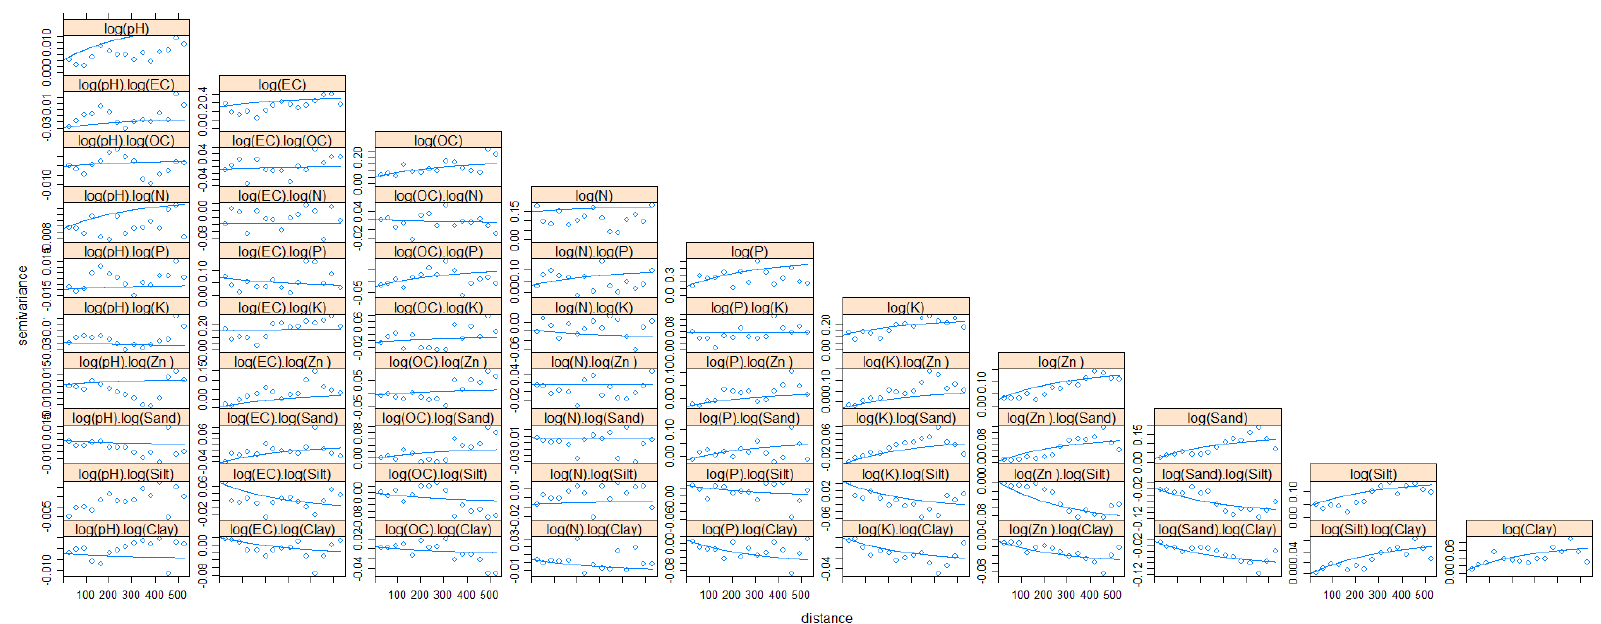
Figure 3. System comparison of variograms and cross-variograms for soil pH, EC, OC, N, P, K, Zn, sand, silt and clay in the study area.